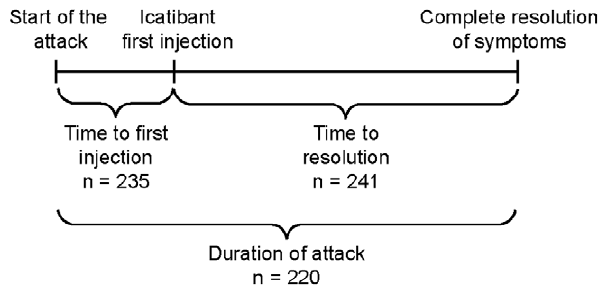
Figure 1. Available time-to-event data for patients with HAE types I and II. { { For each attack experienced by patients in the IOS database, data were collected for time to first injection (time between start of the attack and icatibant first injection [n=235 attacks]), time to resolution (time between icatibant first injection and complete resolution of symptoms [n=241 attacks]) and duration of attack (time between start of the attack and complete resolution of symptoms [n=220